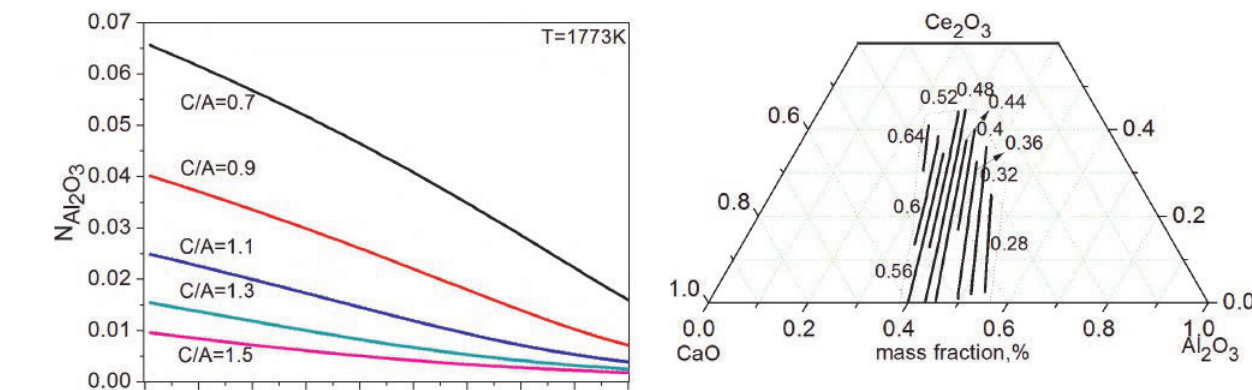
O at 1773 K 2 3